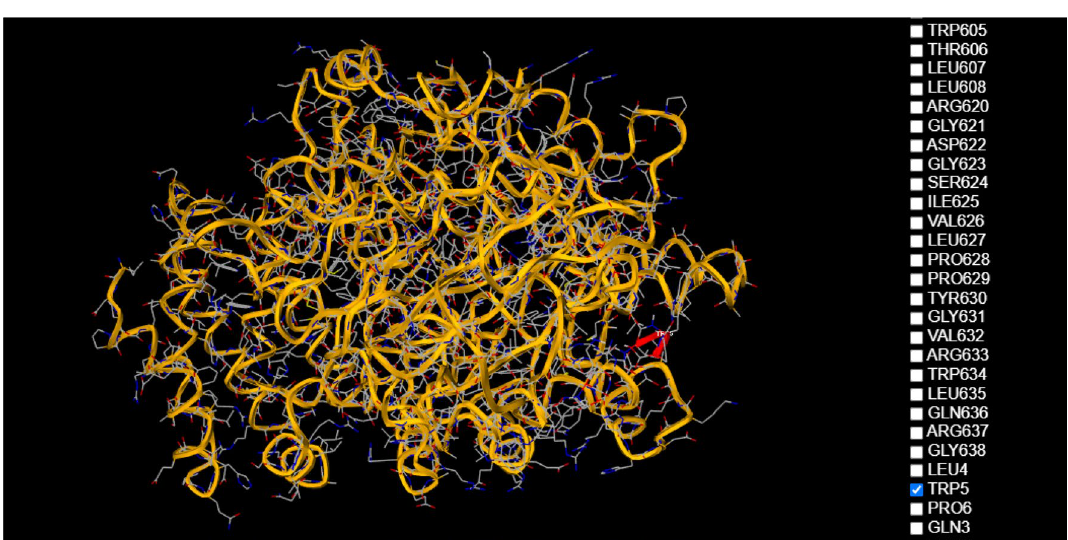
Figure 14. Bounding of the sucrose molecule near TRP5 obtained using 1-CLICK DOCKING Software from the mcule platform, version from 2011, https:// mcule. com/ apps/1- click- docki